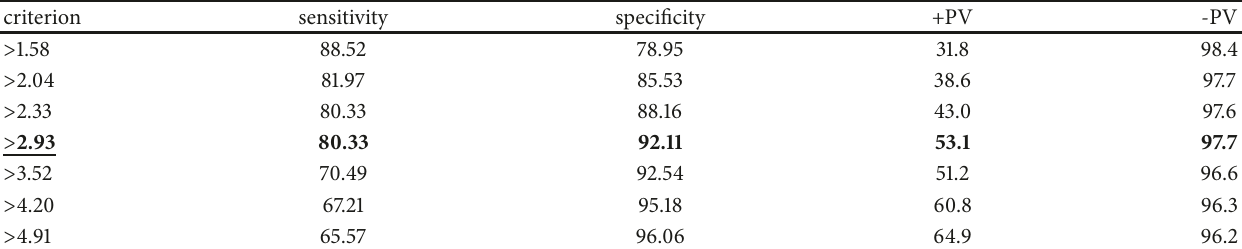
Table 4: Sensitivity, specificity, positive predictive value, and negative predictive value of different cutoff values of ADRR.